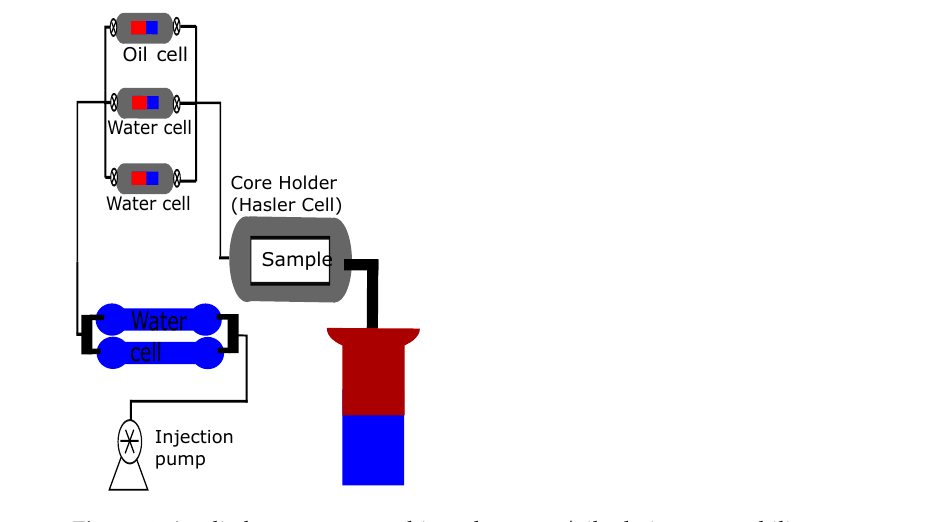
Figure 4. Applied apparatus to achieve the water/oil relative permeability tests